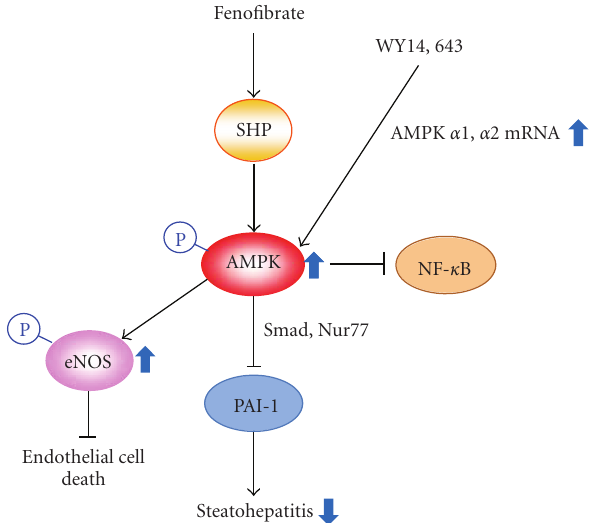
Figure 4: The e ff ects of PPAR α activators on AMPK-dependent functions. eNOS: endothelial nitrogen oxide synthase; NF- κ B: nuclear factor- κ B; PAI-1: plasminogen activator inhibitor-1; SHP, small heterodimer